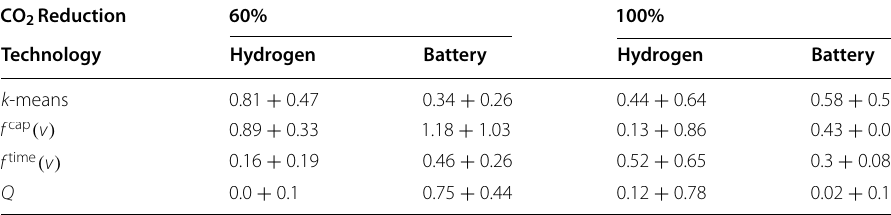
Table 9 Analogous to Table 8, however with a spatial resolution of 67 nodes